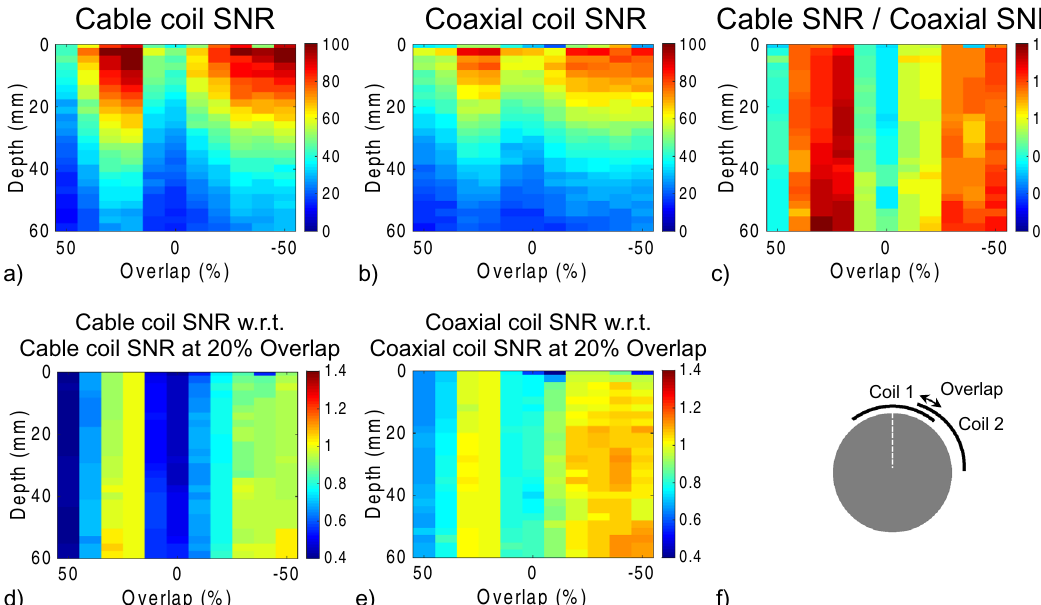
Figure 6. SNR as a function of depth and overlap along the main axis of one coil in two-channel arrays based on cable coils ( a ) or coaxial coils ( b ). Cable coil array SNR normalized by coaxial coil array SNR ( c ). Cable coil SNR normalized by cable coil SNR with 20% overlap ( d ), which is the approximate position that minimized the transmission coefficient (see Fig. 5). Coaxial coil SNR normalized by coaxial coil SNR with 20% overlap ( e ). Overlap is expressed as a percentage of the coil diameter (10-cm). Negative overlaps indicate gaps. Schematic of the setup illustrates the 20% overlap case and shows the SNR profile along the main axis of coil 1 ( f ). Each column of the ratio maps in ( c – e ) was smoothed to improve visualization using a median filter with 11-mm